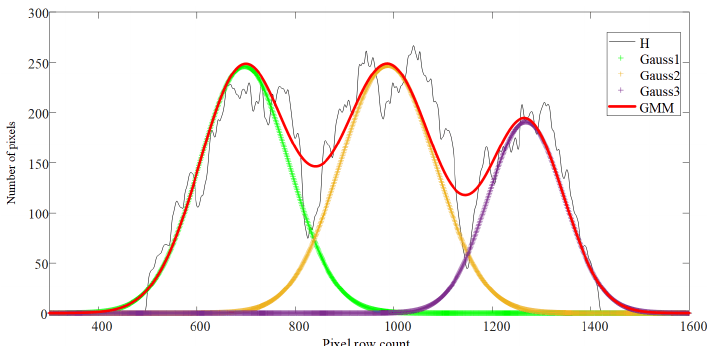
Figure 7. Diagram of Gaussian Mixture Model (GMM) distribution. The red curve is the GMM; the